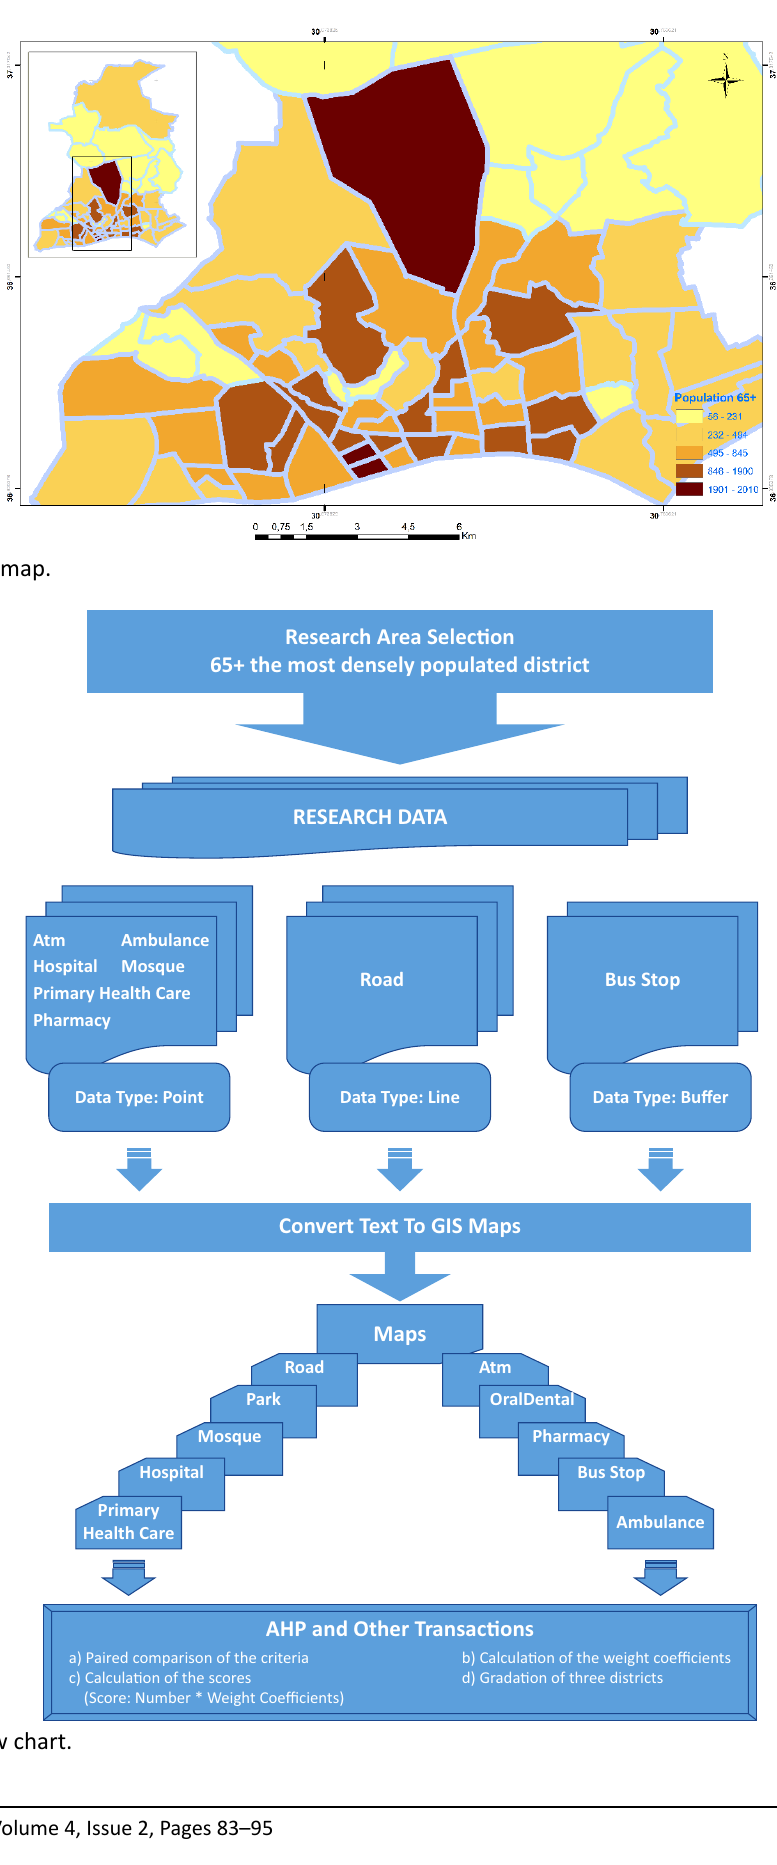
Figure 4. Method flow